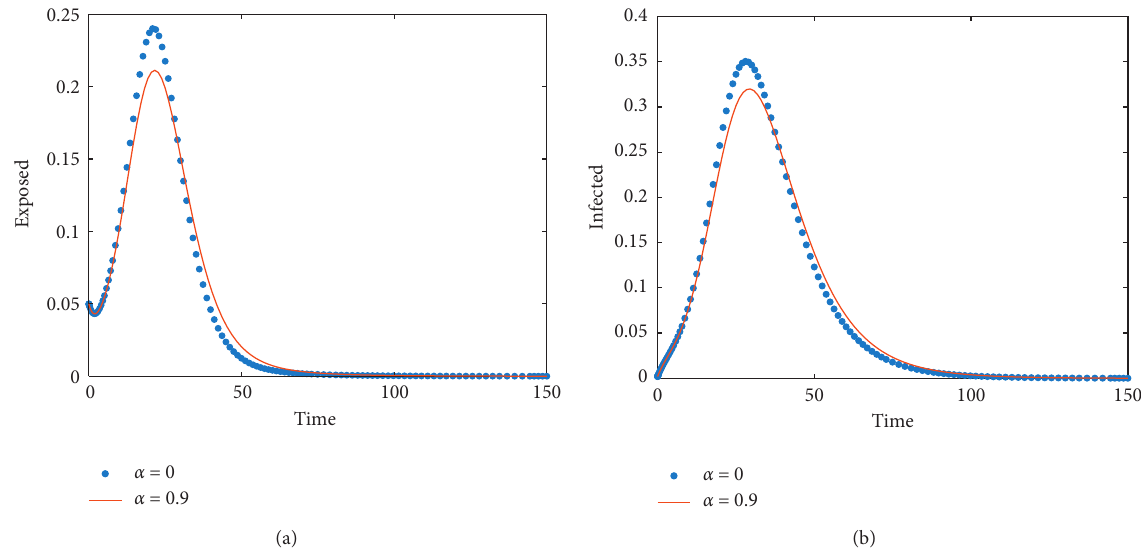
Figure 2: Dynamics of (a) exposed population and (b) infected population over time (days) for increasing value of fear while the disease transmission rate β �